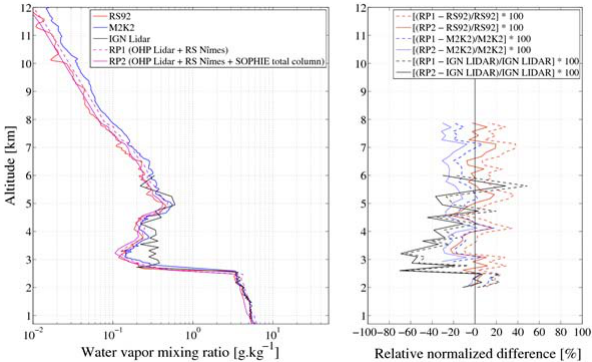
Fig. 7. (Left) Comparison of WVMR profiles measured by NDACC-OHP lidar (magenta lines), IGN-LATMOS lidar (black), and radiosondes (RS92 in red and M2K2DC in blue), on 21 Oc- tober 2011 (balloon launch time: 20:24UTC). Two versions of NDACC-OHP lidar profile are shown (see legend). (Right) Relative differences (%) as indicated in